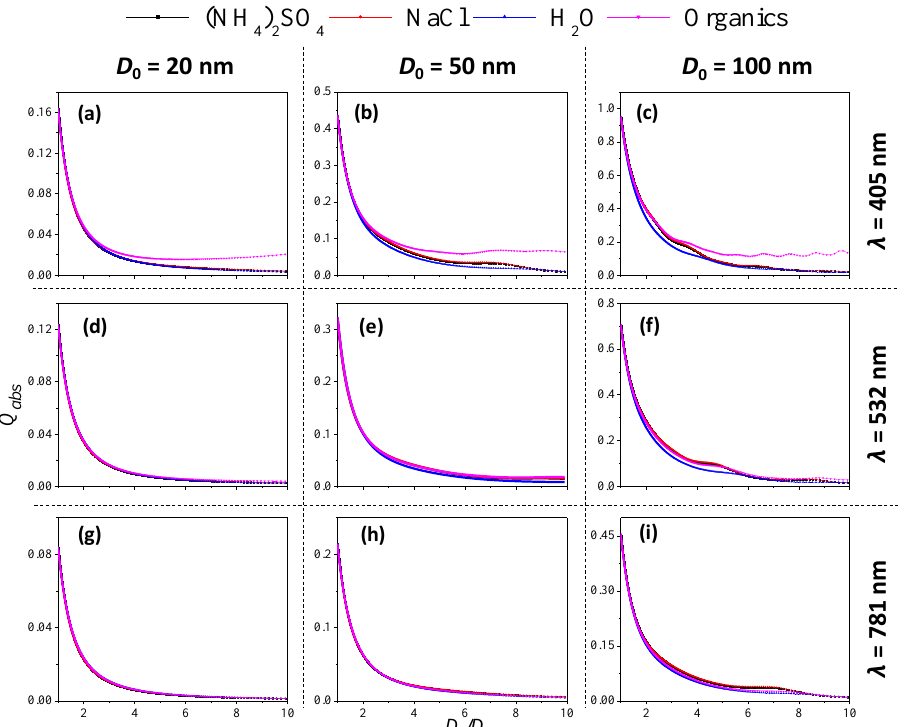
Figure 3. Variation in absorption e ffi ciency ( Q abs ) with coating thickness ( D i / D 0 ) for various soot-particle coated materials ( λ = 405, 532 and 781 nm; soot particle core diameter D 0 = 20, 50 and 100 nm). ( a – c ): ( λ = 405 nm; soot particle core diameter D 0 = 20, 50 and 100 nm); ( d – f ): ( λ = 532 nm; soot particle core diameter D 0 = 20, 50 and 100 nm); ( g – i ): ( λ = 781 nm; soot particle core diameter D 0 = 20, 50 and 100 nm);